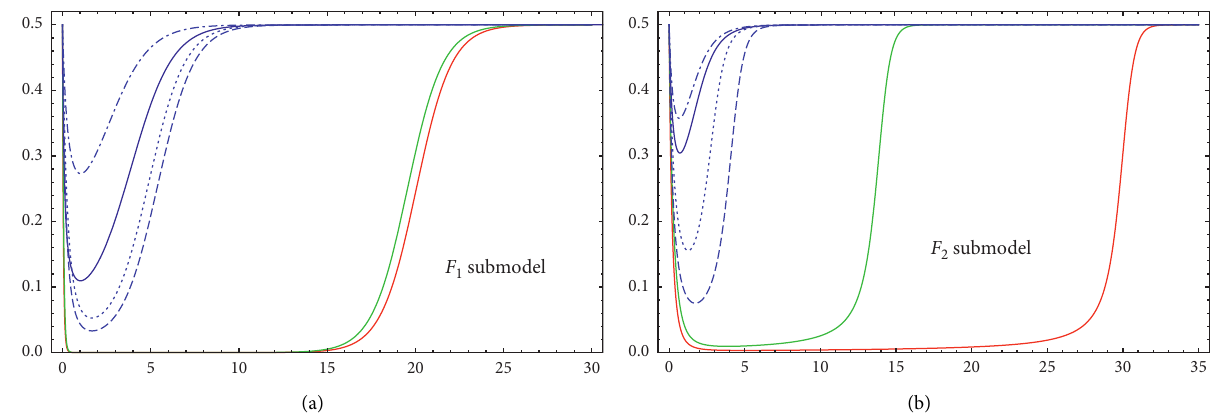
Figure 1: Plots of N ( t ) for single release strategy in cases of F correspond to M